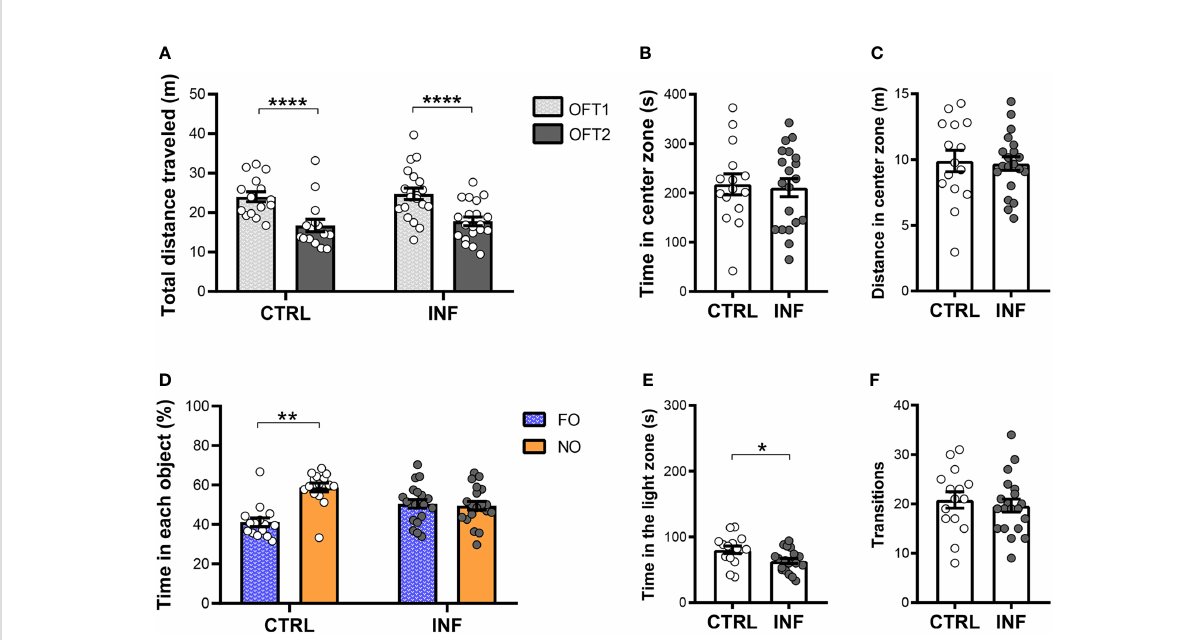
FIGURE 5 Effect of non-severe Plasmodium berghei ANKA infection in mice in behavioral performance in different paradigms 145 days after the end of treatment (dpt). (A) Total distance traveled in meters (m) in open fi eld test (OFT1 and OFT2) 30 × 30 × 30 cm arena. (B) Time in center zone (seconds, s). (C) Distance in center zone (m) in fi rst session of OFT. (D) Time in objects in percentage (%) in test session in the NORT. (E) Time in the light zone (s). (F) Numbers of transitions between light and dark side in light/dark task. CTRL (control) and INF (infected and treated) mice groups. Data points are identi fi ed as individuals ’ values. Columns represent mean ± S.E.M. Two-way RM ANOVA/Bonferroni was used for intragroup comparison of different sessions (n=15-20/group) and different objects (n=15-20/group). Two-way ANOVA was used for comparison between CTRL vs INF of OFT1 and OFT2, and the p-values were non-signi fi cant (n=15-20/group). Unpaired student t-test was used to compare control and infected group (n=15-20/group). *p<0.05; **p<0.01;